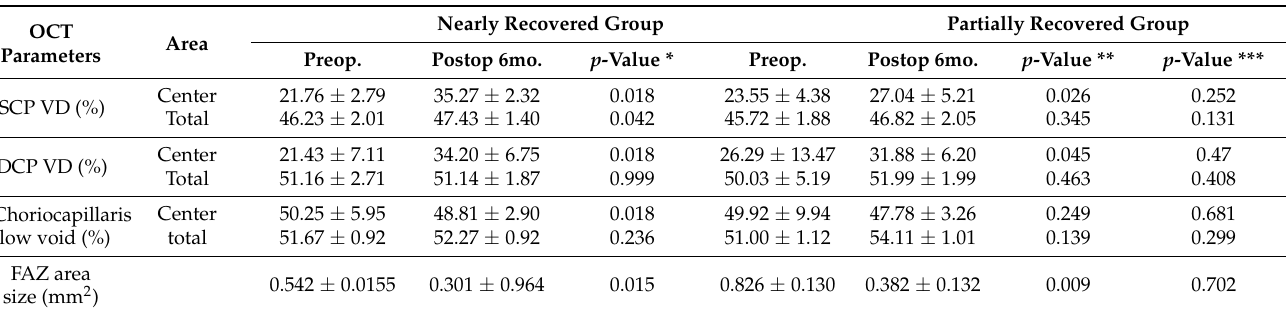
Table 5. Comparison between the vessel density of eyes with the nearly recovered group and the partially recovered group preoperatively and six-months postoperatively.